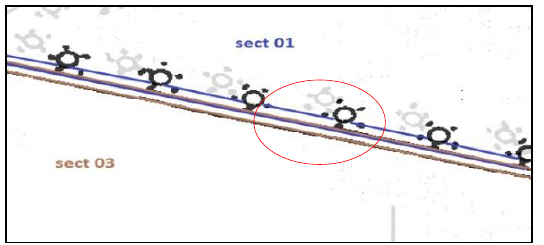
Figure 2. The second form of overlapping problem.